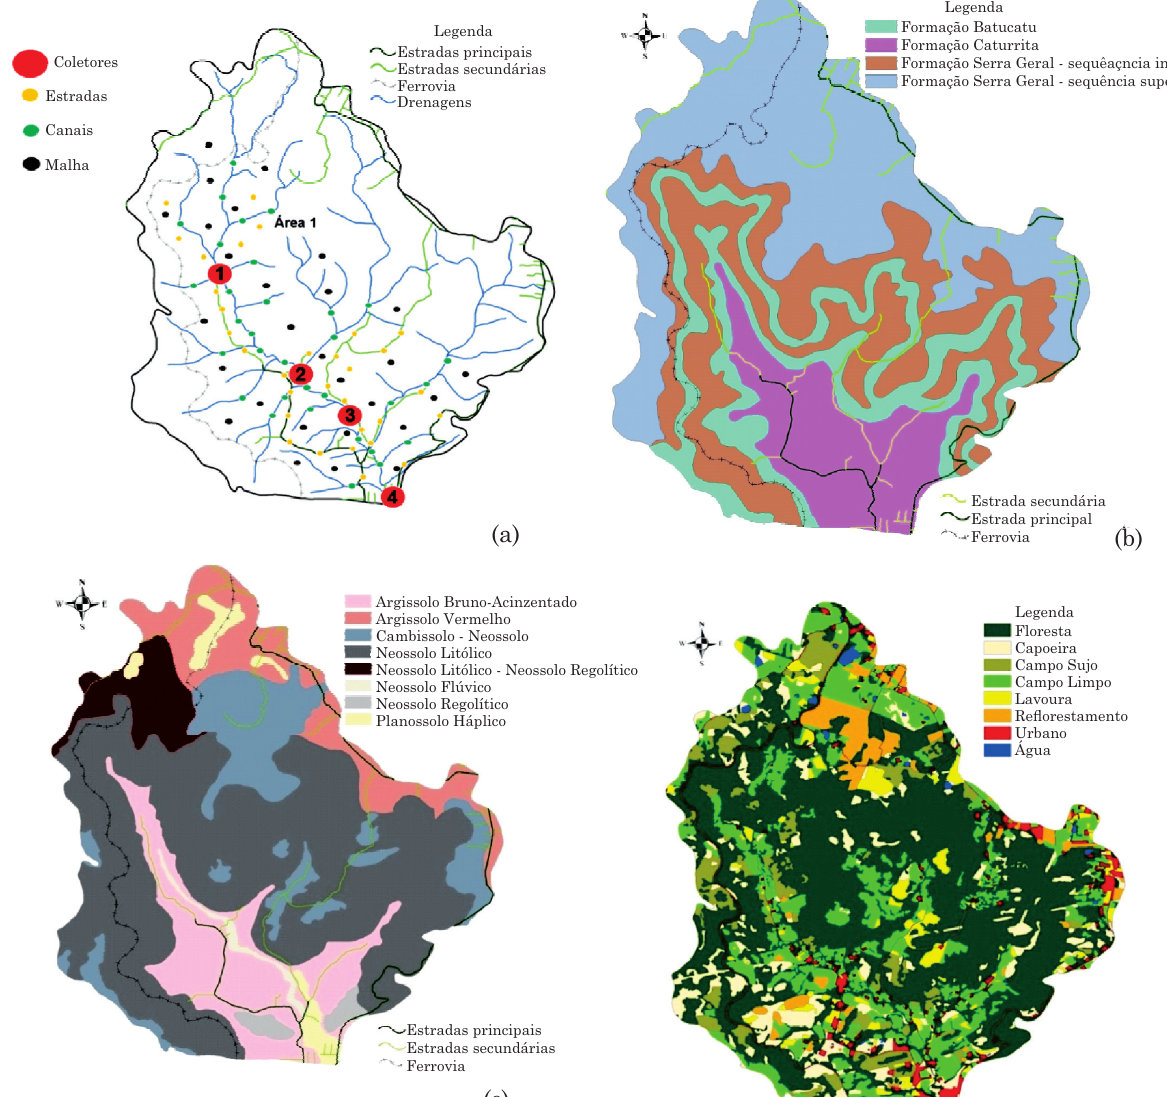
Figura 1. a) Área de estudo com indicação dos locais das coletas das fontes de produção de sedimentos e dos locais de instalação dos coletores de sedimentos em suspensão (CSS). b) Mapa geológico (Maciel Filho, 1990), c) Mapa pedológico (Miguel et al., 2011), d) Mapa de uso da terra de 2008/2009 (Samuel Rosa et al.,